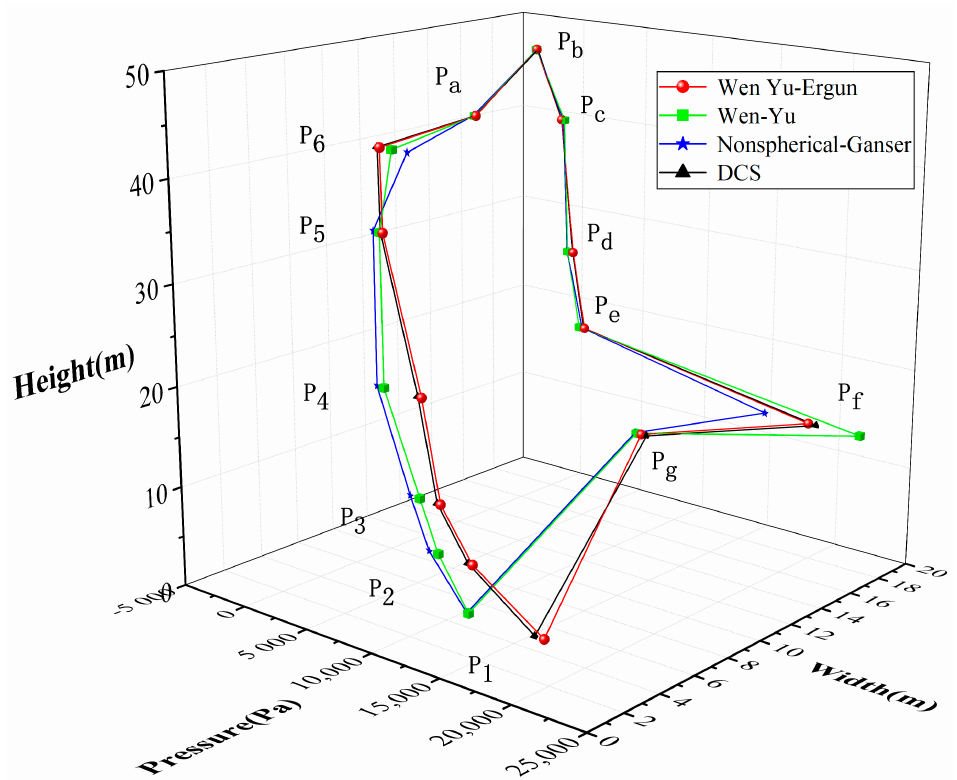
Figure 12. E ff ect of drag model on pressure distribution of the circuit. Figure 12. Effect of drag model on pressure distribution of the circuit.